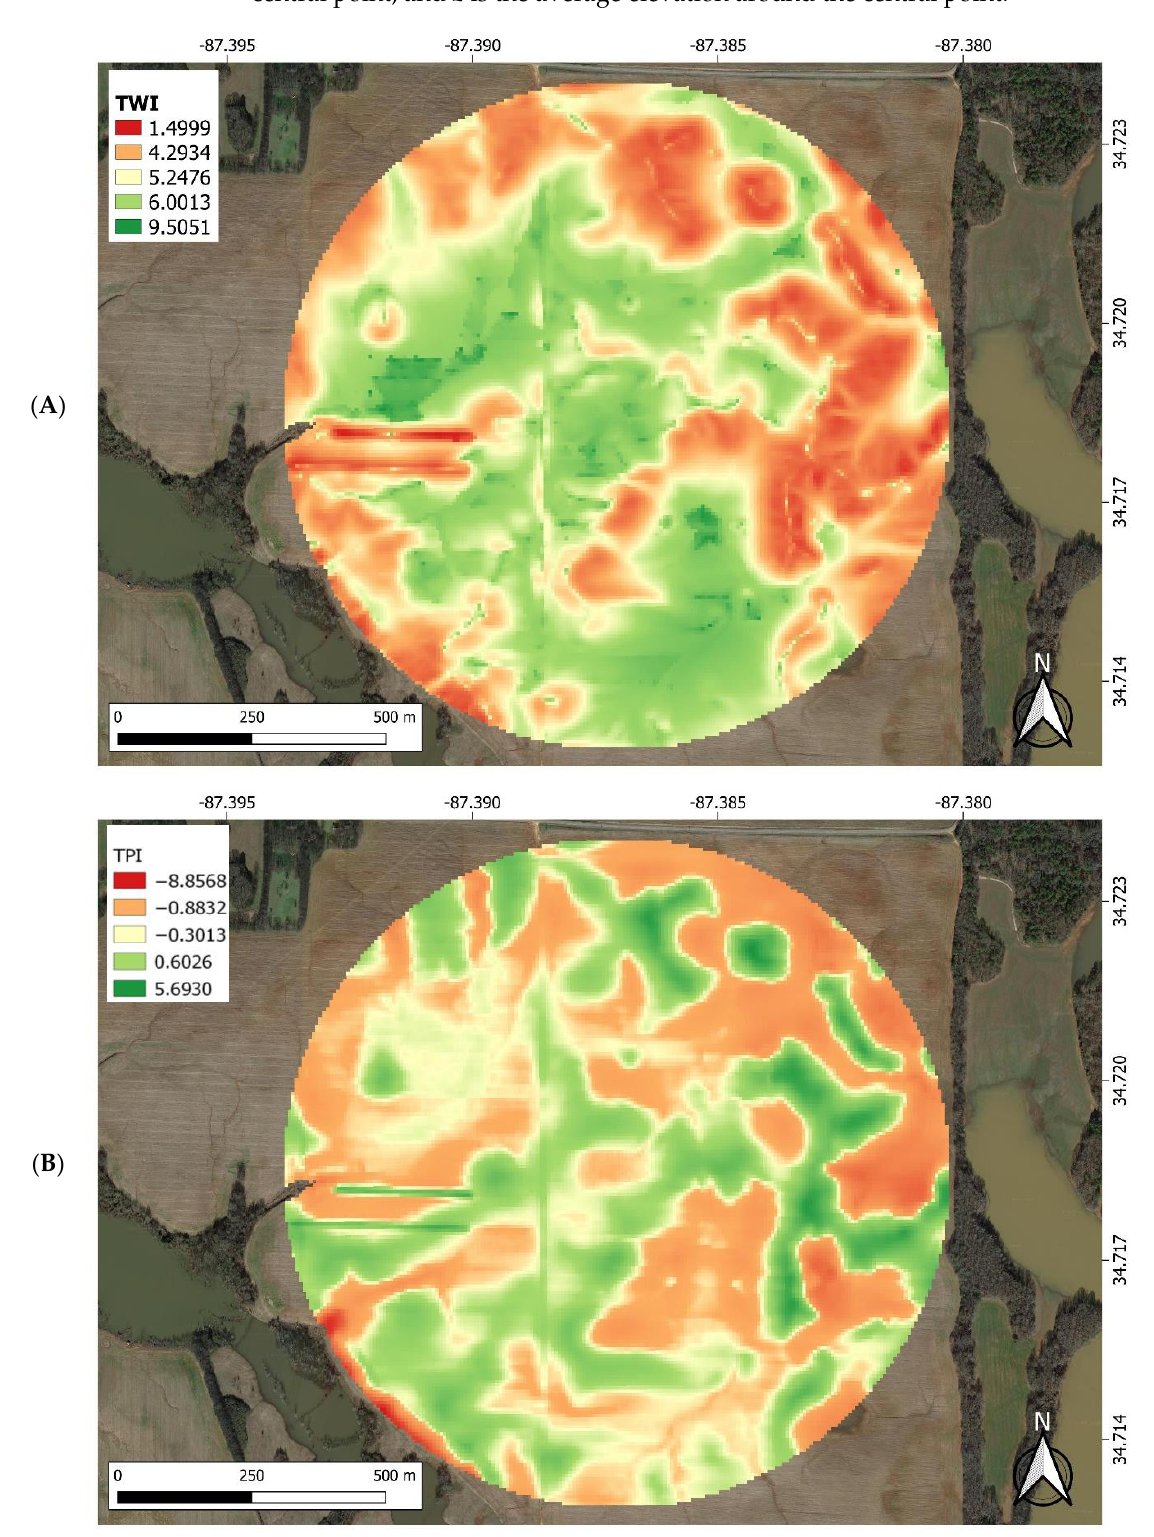
Figure 4. Field variability for topographic indices (topographic wetness index ( A ) and topographic position index TPI ( B )).